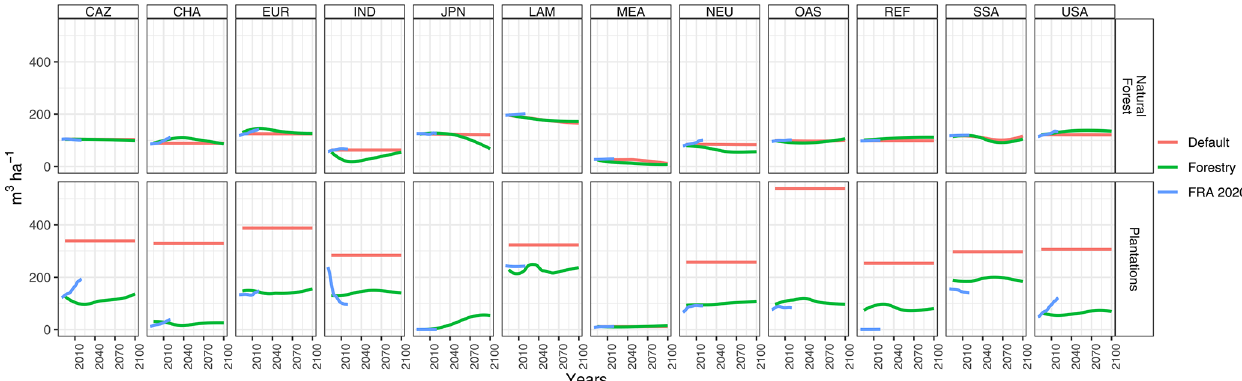
Figure A8. Regional growing stocks in natural forests and plantations (in m 3 ha − 1 ).